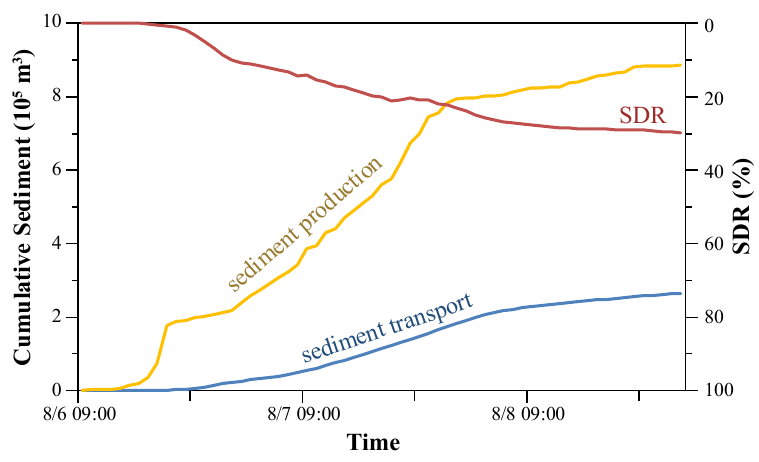
Figure 9. Cumulative sediment production and discharge and the sediment delivery ratio of Typhoon